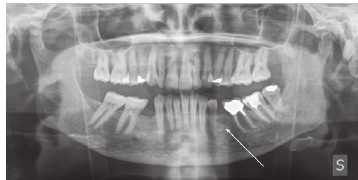
Figure 1: Initial clinical manifestation. A small radiolucent area (arrow) is revealed near mobile dental element 34. Chronic peri- odontitis is present.